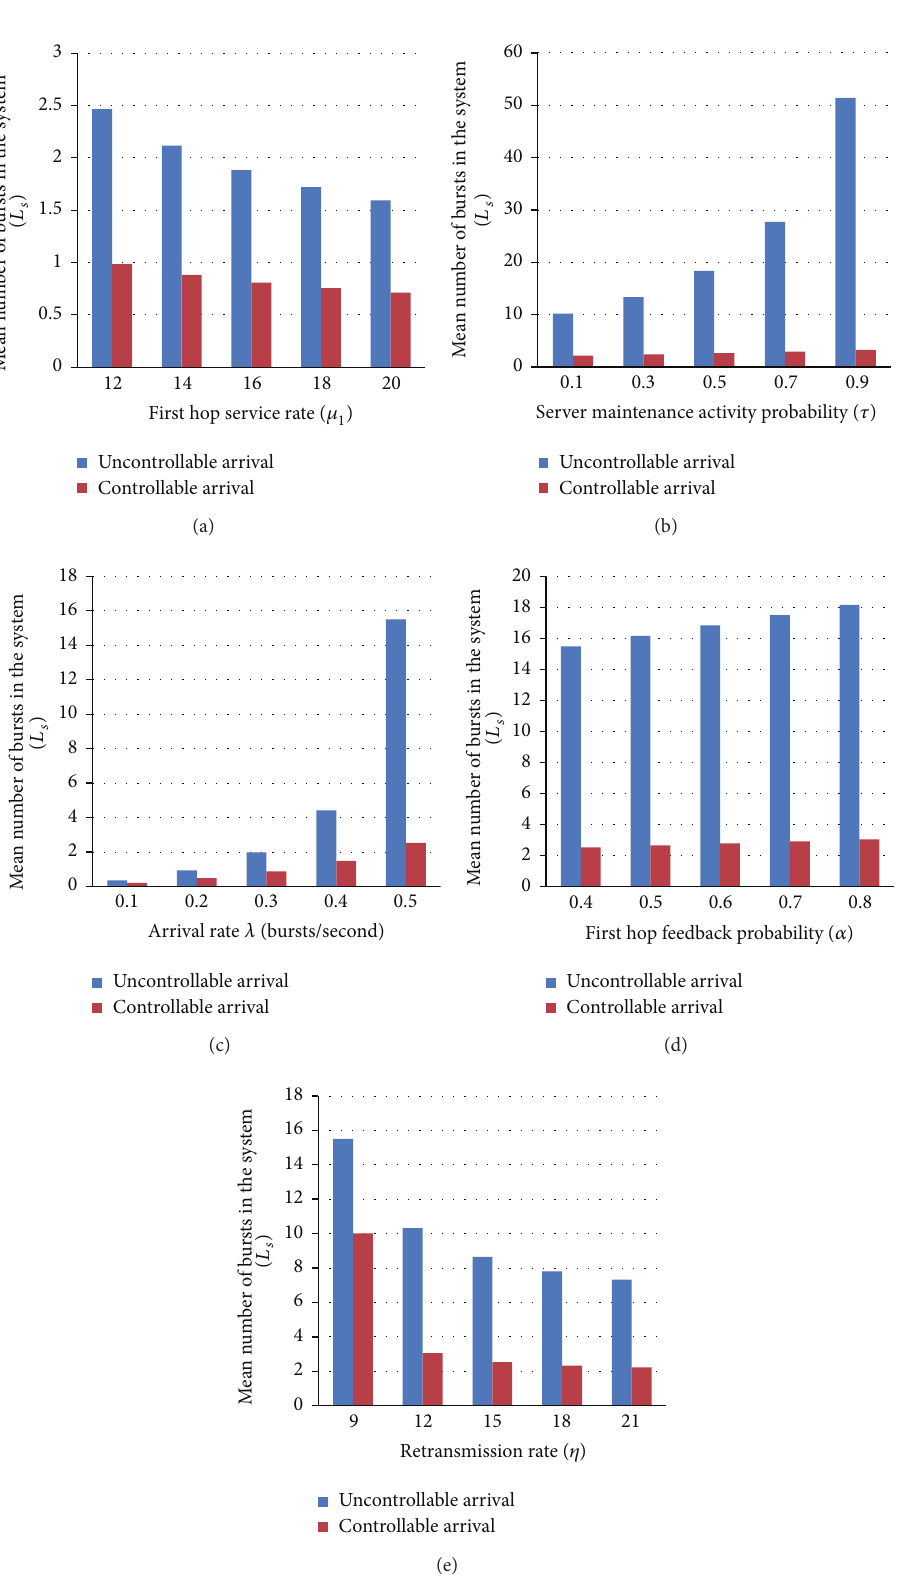
Figure 4: (a) First hop service rate versus mean number of bursts in the system. (b) Server maintenance activity probability versus mean number of bursts in the system. (c) Arrival rate versus mean number of bursts in the system. (d) First hop feedback probability versus mean number of bursts in the system. (e) Retransmission rate versus mean number of bursts in the